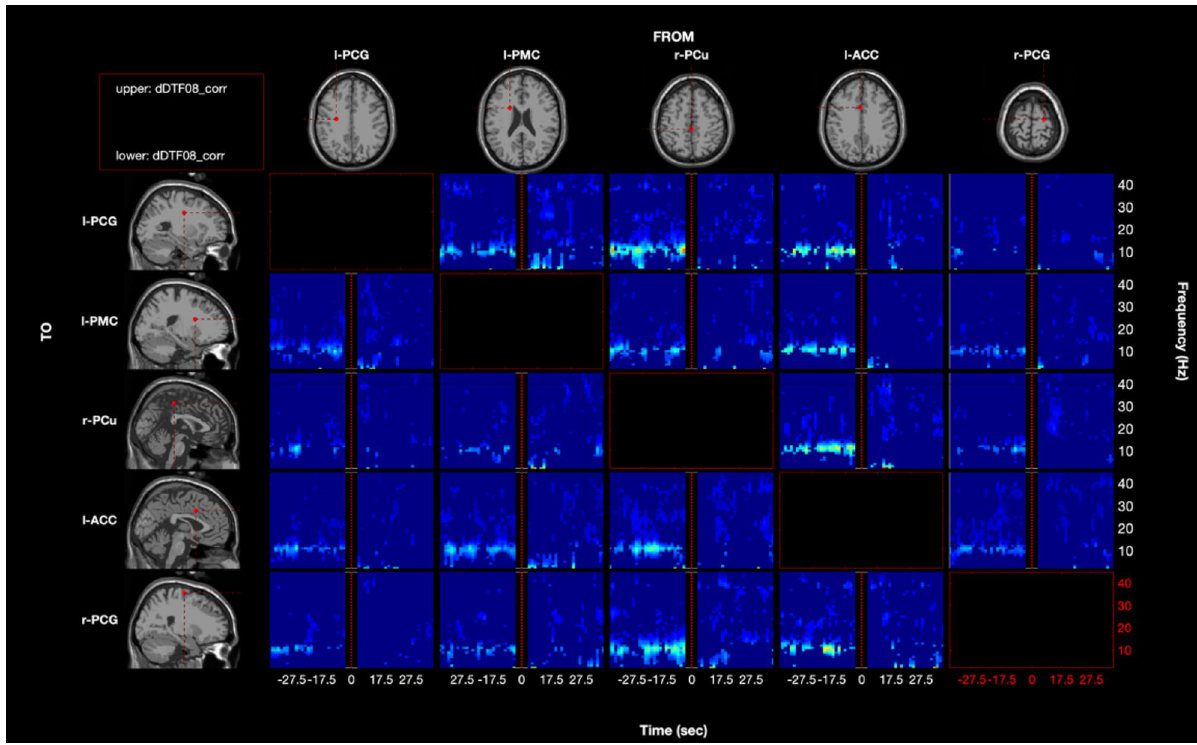
Figure 4. Time-frequency representation of group-median direct Directed Transfer Function (dDTF) between network nodes (i.e., l-PCG, l-PMC, r-PCu, l-ACC and r-PCG). Only values significantly different from 0 after surrogate data testing with phase randomization are reported ( p < 0.05 , corrected with FDR). Time is represented along the x-axis, whereas frequency is represented along the y-axis. Intersections between columns and rows depict directional causal information flow from one node (i.e., source) to another (i.e., sink). dDTF was evaluated in the time range from − 35 s to − 5 s (i.e., resting-state) and from +5s to +35s (i.e., CPT), with respect to the CPT start (i.e., vertical red dashed line at 0s), using a 5s moving window with a shift of 1s, and in the frequency range from 1Hz to 45Hz. Each point over time accounts for the dDTF between − 2.5 s and − 2.5 s. We did not analyze windows overlapping between resting-state and CPT (i.e., black areas from − 5 s to + 5